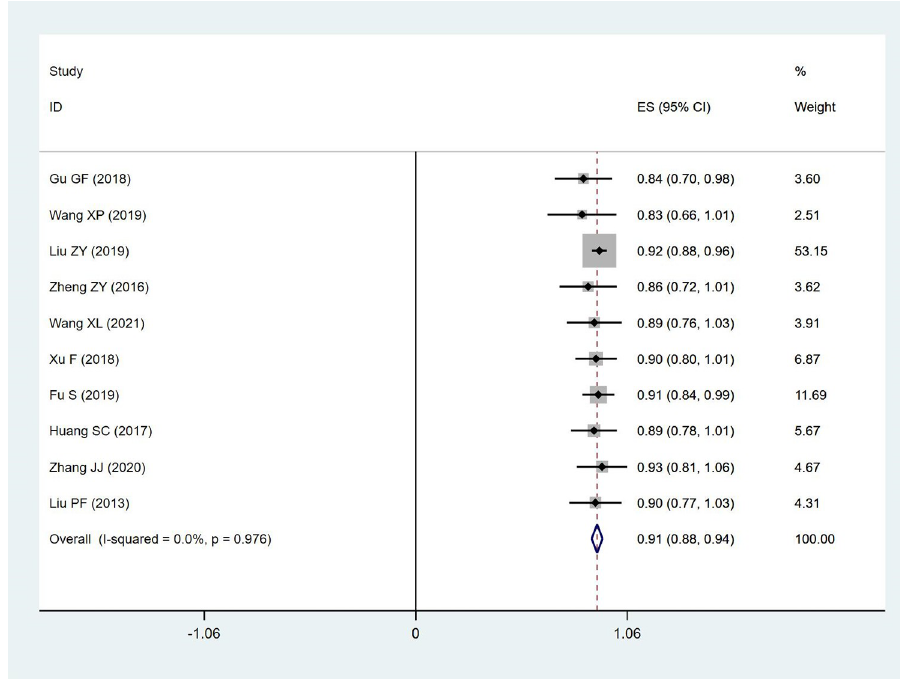
Fig 5. Forest plot of MacNab